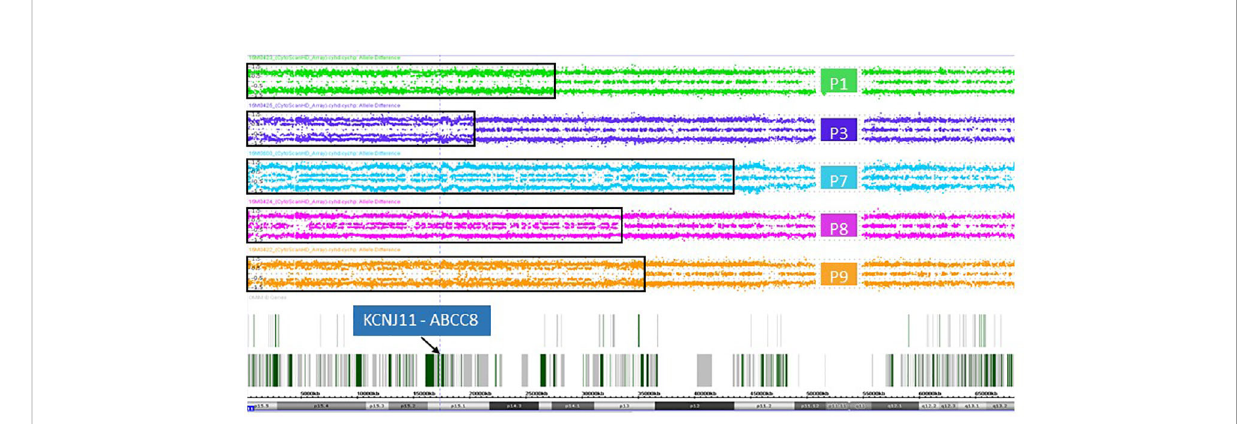
FIGURE 1 Allele difference plots of chromosome 11 on DNA extracted from pancreatic lesions of patient 1 (green panel), patient 3 (purple panel), patient 7 (blue panel), patient 8 (magenta panel) and patient 9 (orange panel) show a mosaic pattern of segmental uniparental disomy (UPD) of the short arm of chromosome 11 of different sizes. The extent of the UPD regions indicated by the black rectangles. The vertical dotted line and the arrow indicates the location of the genes KCNJ11 and ABCC8 , which are located within the UPD region in all fi ve patient samples.